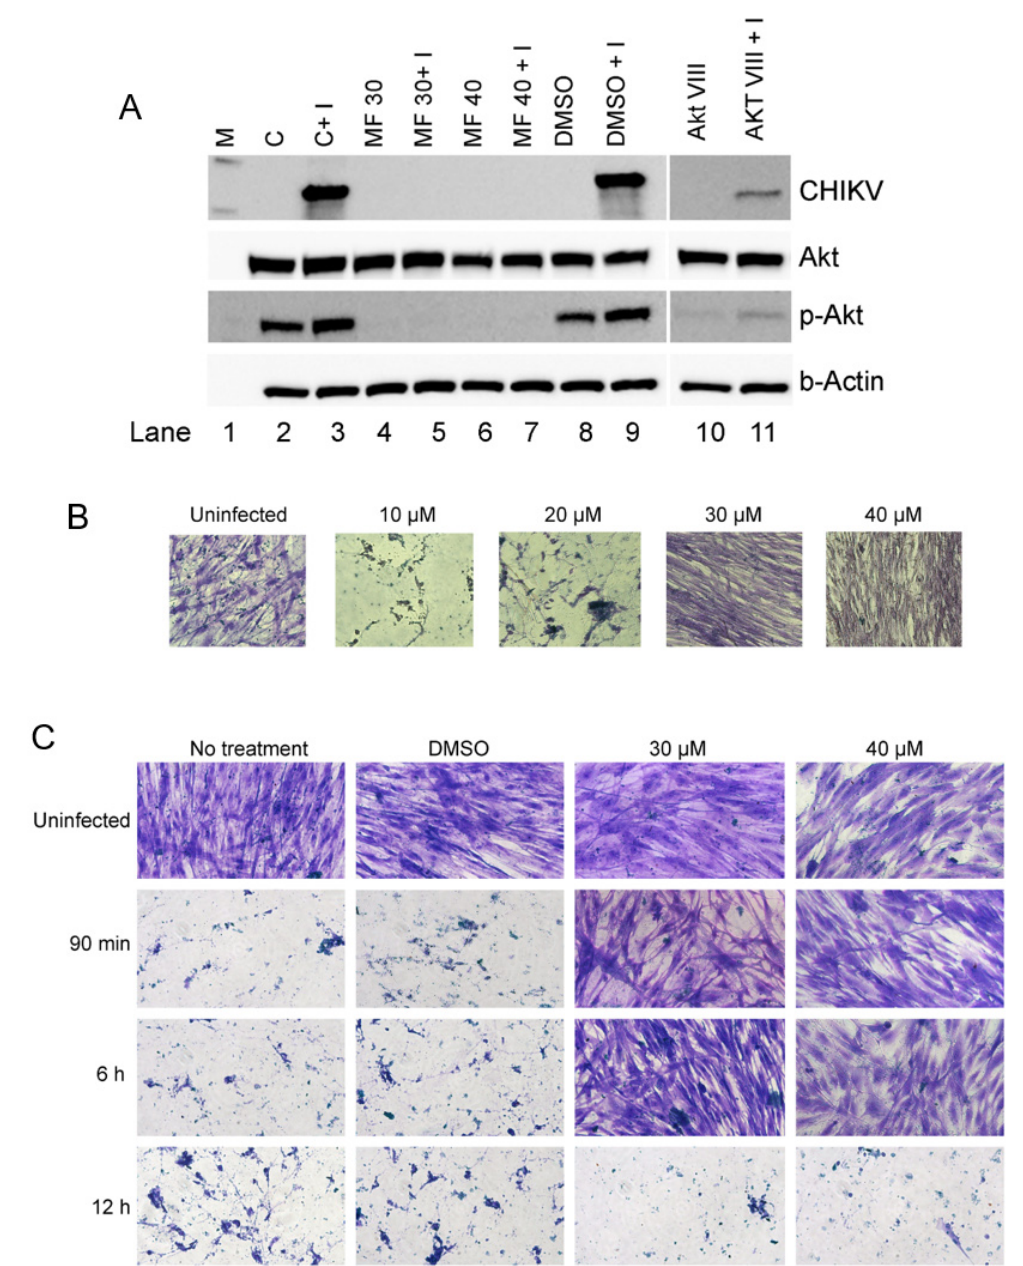
Figure 5. Effect of MF treatment on Akt-phosphorylation and cell growth in CHIKV infected cells. ( A ) The cell lysates of hPDF cells infected with CHIKV181/25 were analyzed for native Akt, p-Akt, and CHIKV antigen levels by western blot analysis. Reduction in levels of CHIKV antigen was found to be concomitant with that of the reduction in the levels of p-Akt. M= ladder, C= Control uninfected cells, I = infected, and DMSO = dimethyl sulfoxide. ( B ) Cells were treated with corresponding doses of MF for 4–5 h and infected with CHIKV181/25 (MOI=1). After 72 h pi, virus and drug were removed and cells were washed, replenished with fresh media and incubated for 4 days. ( C ) Cells were infected with CHIKV181/25 (MOI=1) and treated with MF at the indicated time points post-infection. After 72 h pi, virus and drug were removed and cells were washed and replenished with fresh medium and incubated for 4 days. B and C : Cells were fixed and stained overnight with 10% neutral buffered formalin containing 0.1% crystal violet and subsequently washed gently under running tap water and observed under the microscope. Data is representative of two repeat